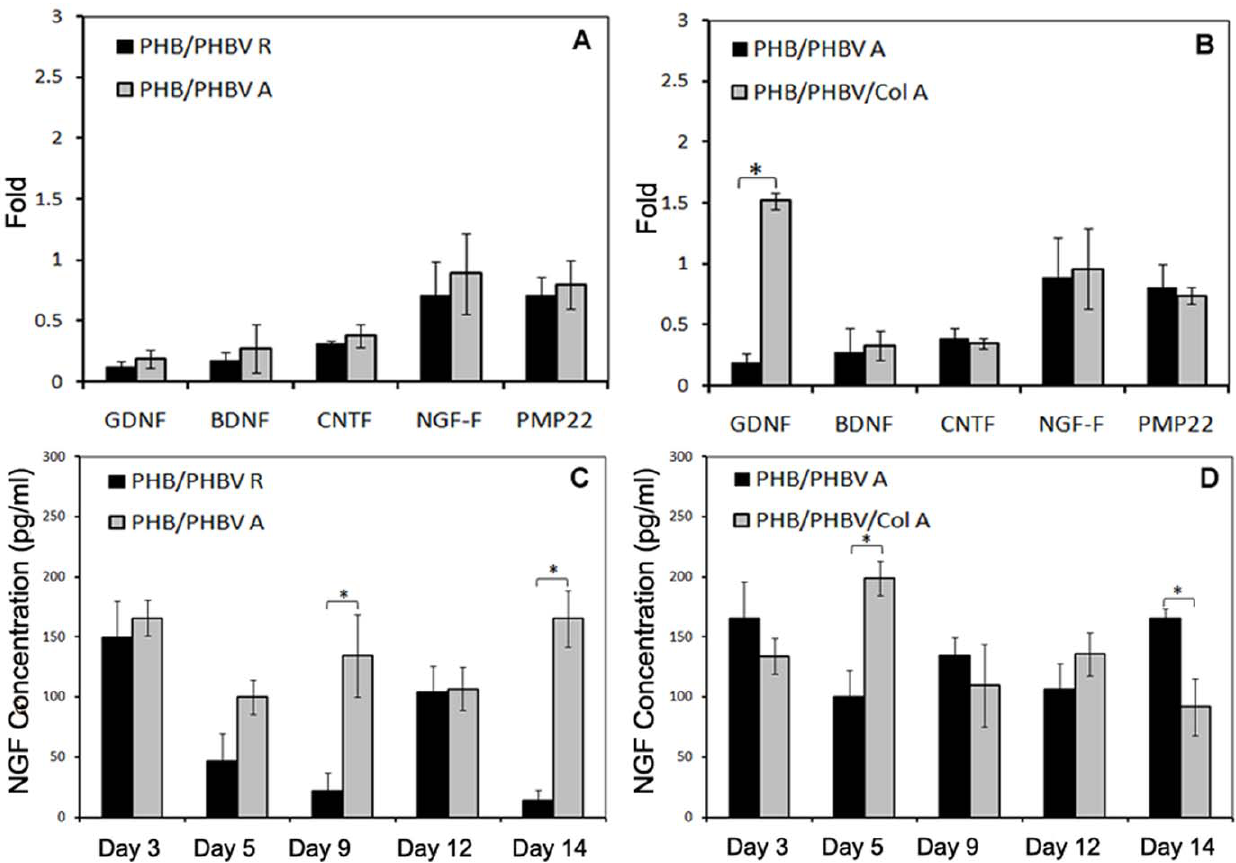
Figure 9. Real-time PCR analysis and NGF assay results to compare gene expression and secretions of NGF released from SCs. (A, C) PHB(50)/PHBV(50) random nanofibers (PHB/PHBV R group) and PHB(50)/PHBV(50) aligned nanofibers (PHB/PHBV A group); (B, D) PHB(50)/PHBV(50) aligned nanofibers (PHB/PHBV A group) and PHB(45)/PHBV(45)/collagen(10) aligned nanofibers (PHB/PHBV/Col group) during 14 days of culture. Asterisks represent significant difference at p #